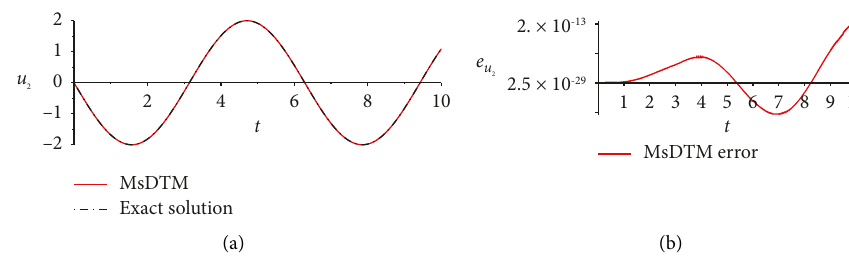
Figure 2: The approximate solution component u 0.51